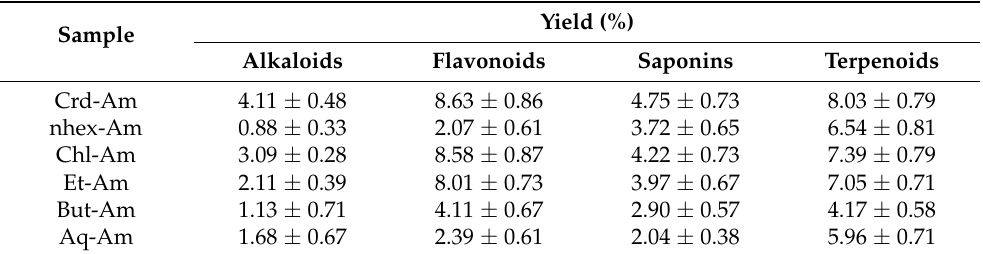
Table 2. Non-spectrophotometric quantitative phytochemical analysis of crude extract and